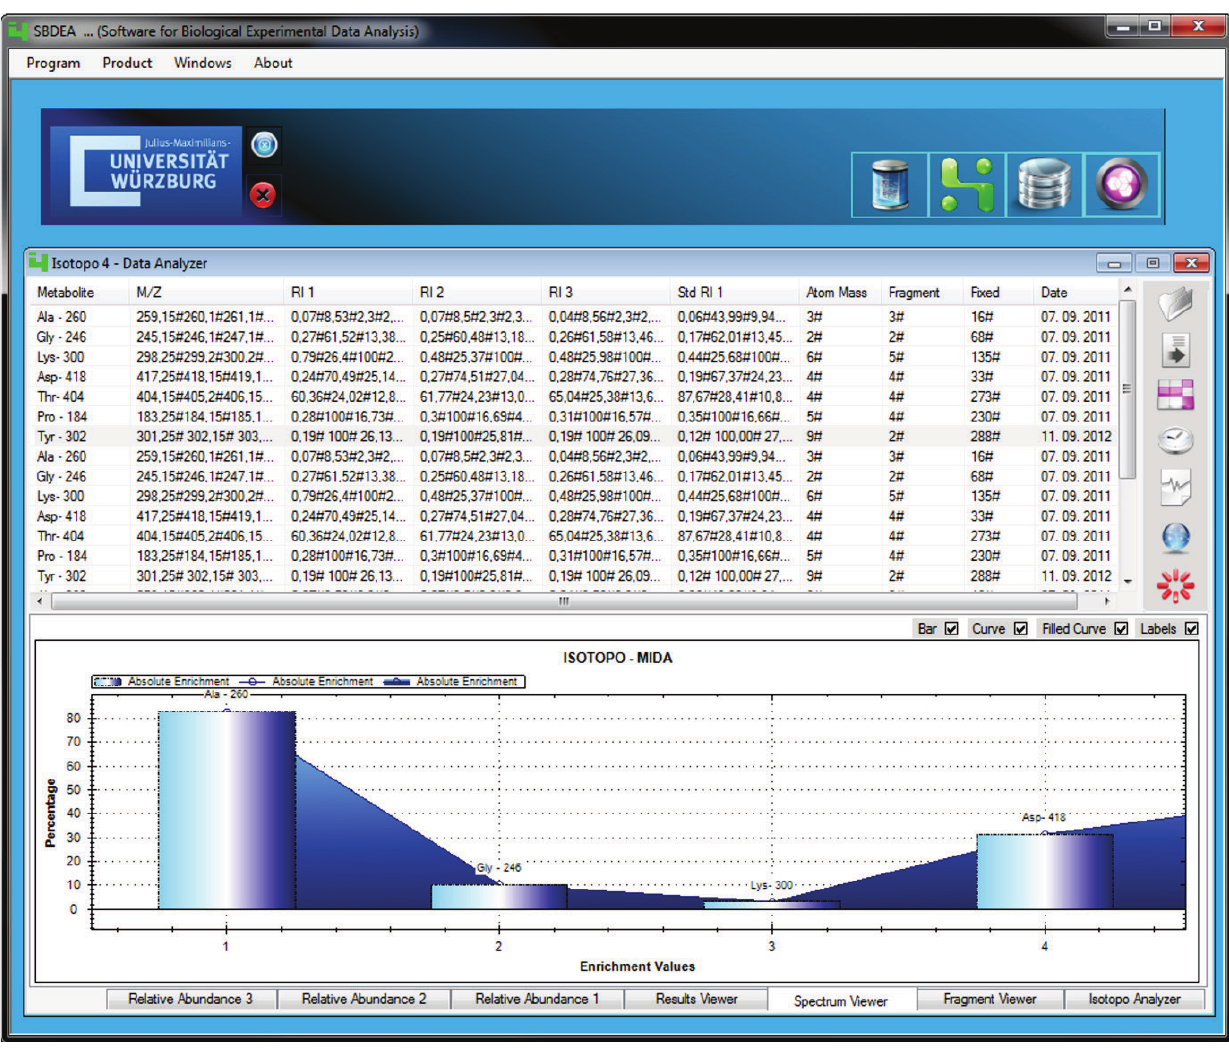
Figure 11. Isotopo Data Analyzer’s main graphical user interface. Scientific software solution towards bioinformatics and biochemistry, with the ability of performing quantitative mass spectrometry to mixtures of materials labeled with stable isotopes. It provides